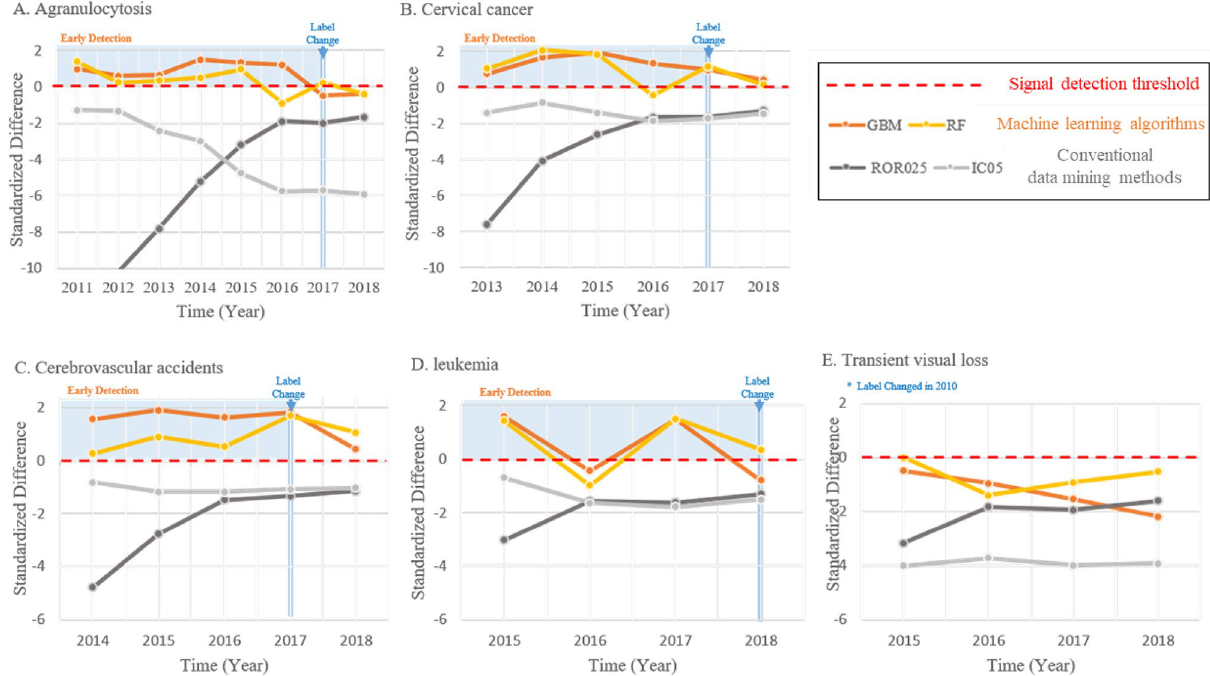
Figure 1. Standardized differences of data mining methods by calendar year for each pre-specified AE updated in the labeling information of infliximab Abbreviations: AE, adverse event; GBM, gradient boosting machine; RF, random forest; ROR025, adjusted reporting odds ratio; IC05, information